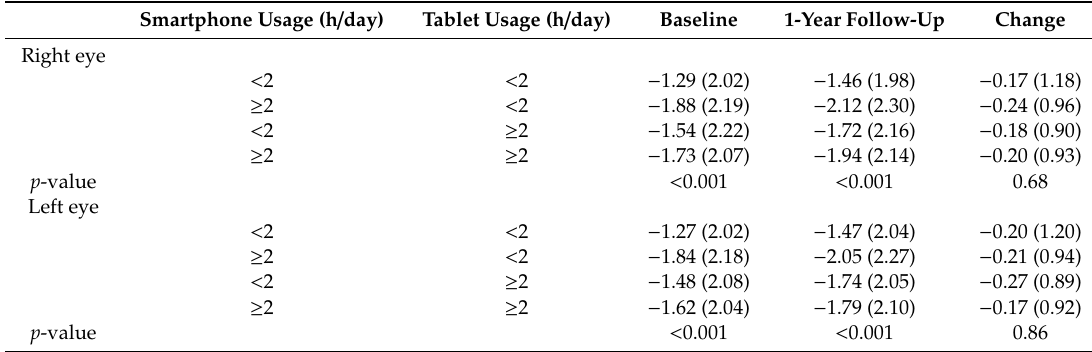
Table 5. Interactive association between smartphone and tablet usage (hours per day) on spherical equivalent refraction (SER, D).